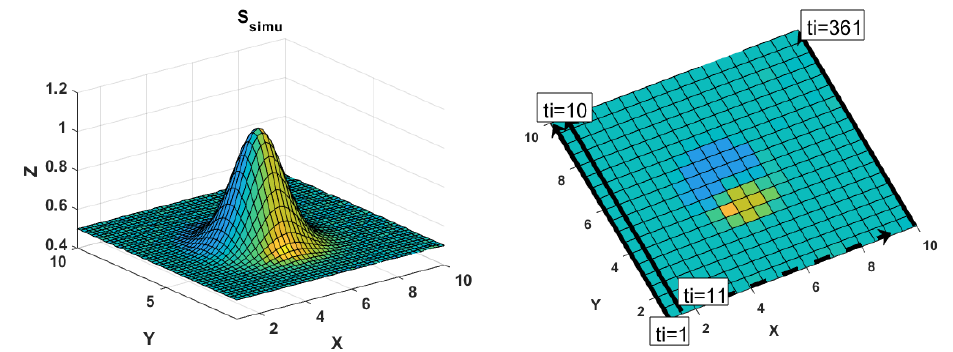
Figure 1. Left : the reference surface corresponds to a Gaussian probability density function. Right : time in increasing order starting at the beginning of each row is associated with each point. The time needed by the terrestrial laser scanner (TLS) to come back to its initial X-position is neglected in a first approximation.